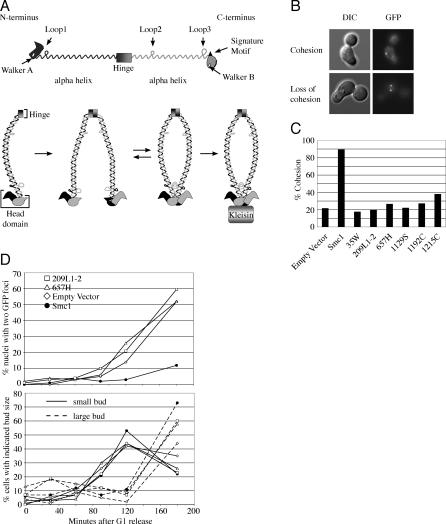
Dominant Negative Insertion Mutants Disrupt Sister Chromatid Cohesion(A) Schematic presents conserved structural and functional features of an Smc protein, folding of an Smc molecule, dimerization with a second Smc protein, and binding of the kleisin subunit (see text).Analysis of sister chromatid cohesion for strains expressing dominant insertion mutants of SMC1 (B–D).(B) A LacO/LacI-GFP-based system was used to assess sister chromatid cohesion. The yeast strain YMM-202 contains a tandem array of Lac Operators inserted 9.7 kb from one end of Chromosome IV, LacI-GFP, and the temperature sensitive smc1–2 allele. Under conditions of functional cohesion, sister chromatids are held in close proximity, resulting in a single GFP focus (top). Loss of cohesion allows sister chromatids to precociously separate, resulting in two GFP foci (bottom).(C) YMM-202 harboring minichromosomes with inducible Smc1 alleles were released from G1 under conditions that inactivate the smc1–2 protein and induce expression of the galactose-regulated allele (see Materials and Methods). Cell cycle progression beyond metaphase was blocked by the addition of nocodazole. Cohesion in the different strains was assessed by counting the number of metaphase-arrested cells with a single GFP focus.(D) YMM-202 harboring minichromosomes with inducible Smc1 alleles were treated as described in (C), except cells were removed at the indicated intervals after release from G1 and assessed for the appearance of separated sister chromatids (two GFP foci) following DNA replication (upper graph). Cell cycle progression was determined by cell morphology (lower graph). The appearance of two GFP foci occurs with a similar timing for strains with an empty vector or two representative insertion mutants, indicating that these mutants fail to establish cohesion.